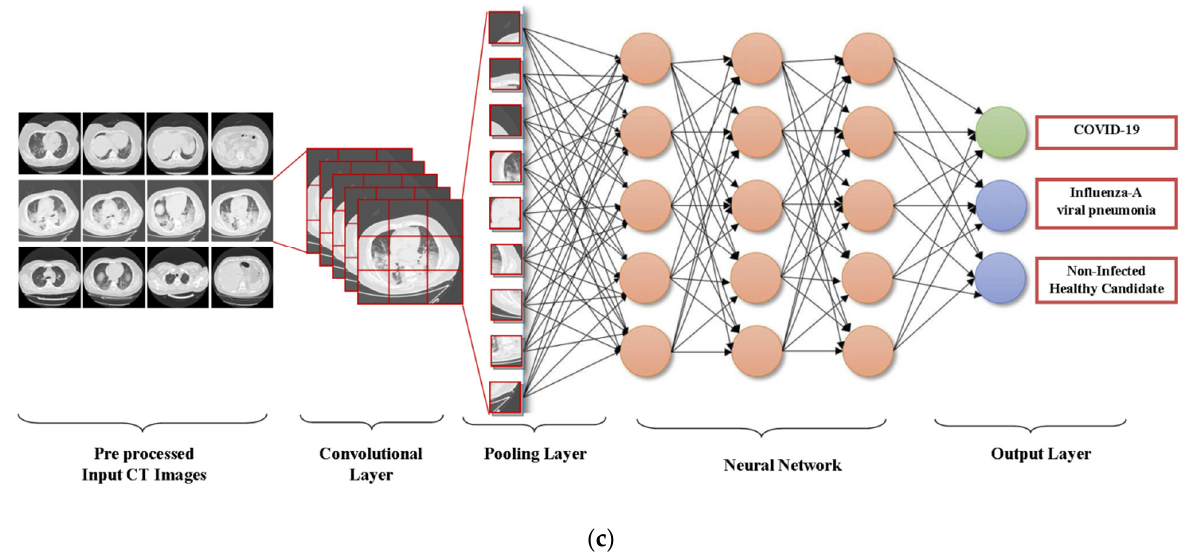
Figure 1. ( a ) Concerned neural network with human deep learning module, ( b ) modeling of research structure, ( c ) a convolutional neural network (CNN) model.